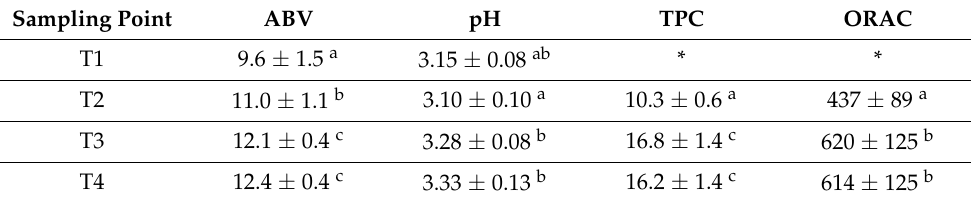
Table 1. Results of the control of ABV (potential alcoholic strength by volume, expressed in alcoholic degrees), pH, TPC (total polyphenolic content, expressed in mg of gallic acid equivalent per 100 mL) and ORAC (oxygen radical absorbance capacity, expressed in µ mol of Trollox equivalent per 100 mL). * Values not measured. Different letters indicate significant differences ( p -value < 0.05). Sampling